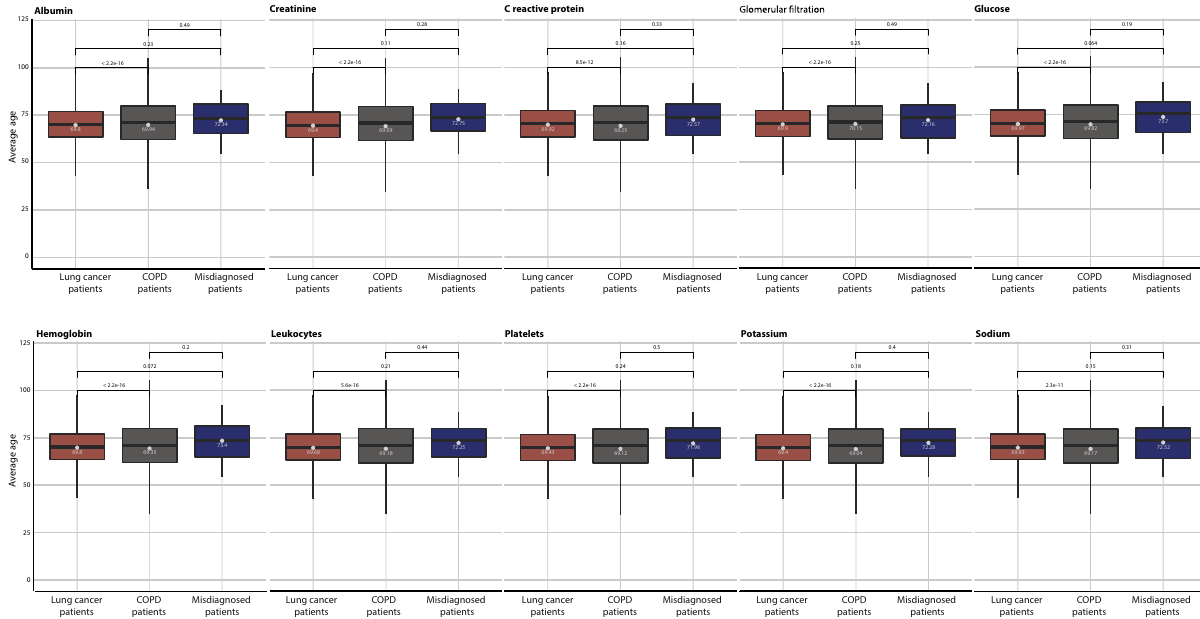
Fig. 7 Distribution of patient ages at the time of laboratory tests. The distribution for the patient ages of the ten most frequently obtained laboratory values from 30 misdiagnosed patients, 22,673 patients diagnosed with lung cancer and 86,340 patients with Chronic Obstructive Pulmonary Disease (COPD). The average patient age for each of the ten laboratory tests was calculated (see Methods). Colours of the boxplots indicate the patient groups. P values for non-parametric paired Wilcoxon – Mann – Whitney tests which compare the mean of the different groups are noted above the